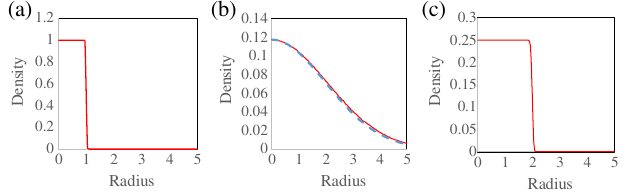
FIG. 4. Transport scheme